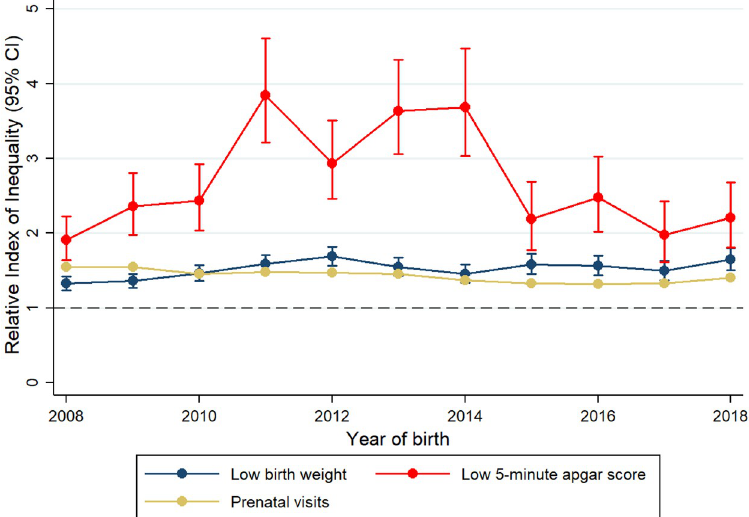
Fig 3. Changes in relative inequalities in birth outcomes and prenatal care by health insurance scheme from 2008 to 2018.